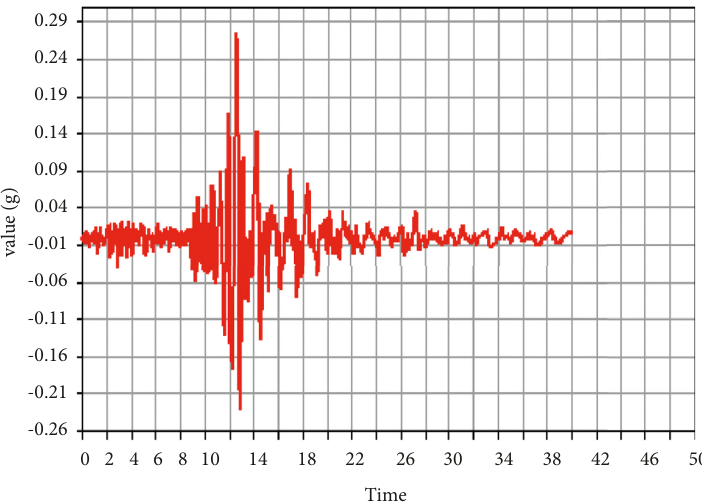
Figure 8: Seismic wave IV (0.2504